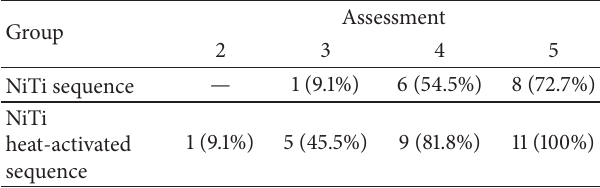
Table 3: Number (%) of cases